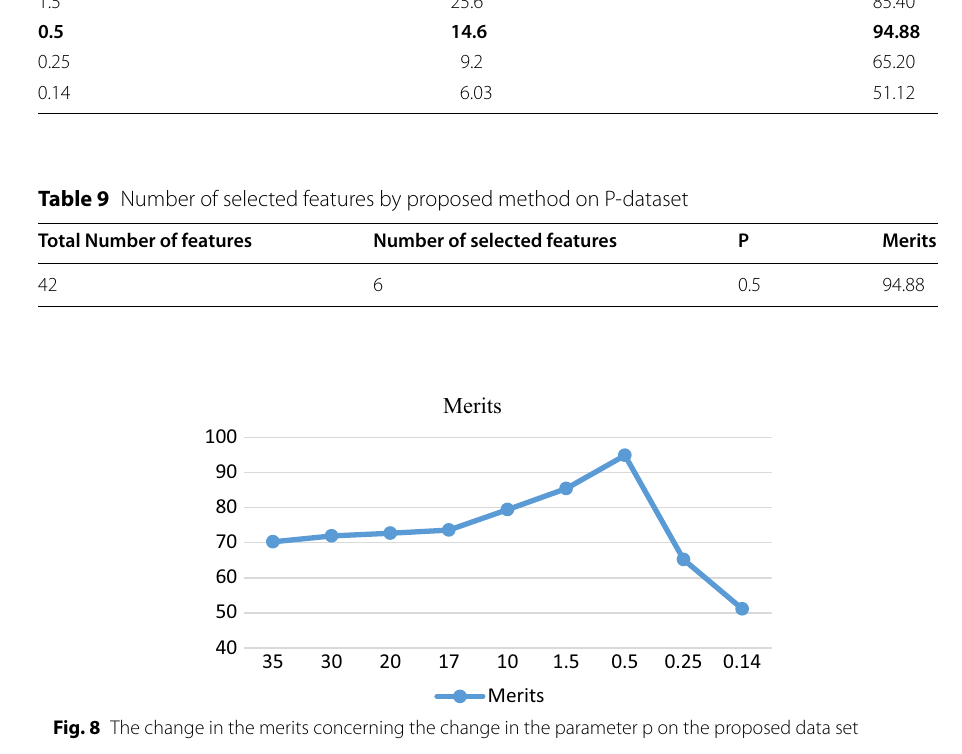
Table 8 Values of m, merits and p parameter of P- dataset P m 35